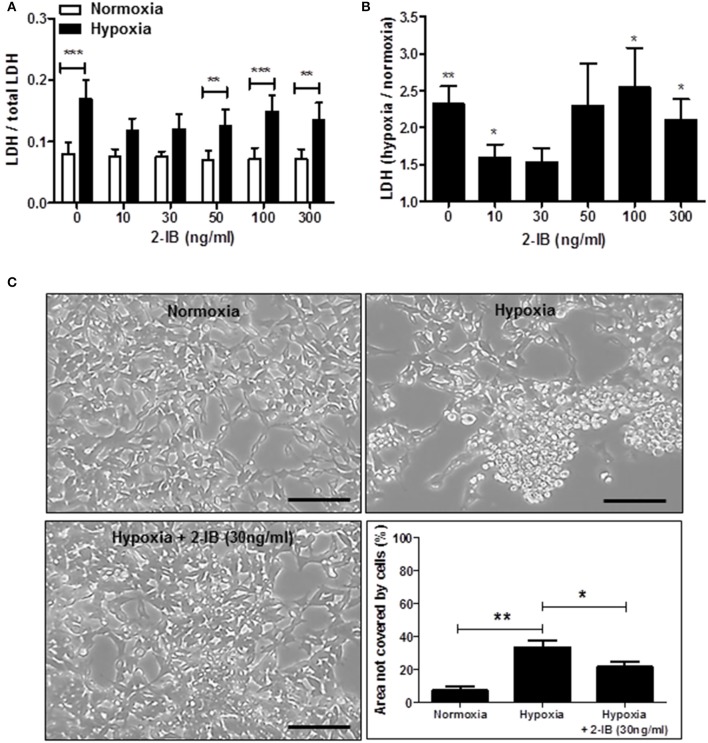
Effects of 2-IB on hypoxia-induced cell damage under hypothermic conditions. (A) LDH release under normoxic and hypoxic conditions. (B) Hypoxia-induced increase in LDH relative to the respective normoxia control (= 1). (C) Morphology of IMR-32 and morphometric quantification of the culture dish area not covered by cells. Columns display the mean; bars denote SEM. Scale bars represent 100 μm. Horizontal lines above the columns assign groups with statistically significant differences (two-way ANOVA in A, one-way ANOVA in C). Asterisks above the columns denote statistically significant differences compared to normoxia (one-sample t-test in B). *P < 0.05; **P < 0.01; ***P < 0.001; N = 5.